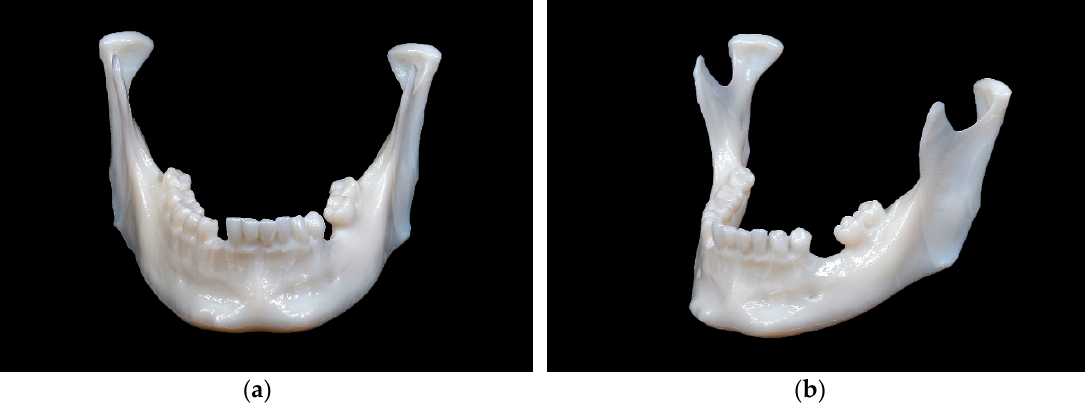
Figure 6. Mandibular model printed in material jetting (MJ) technology: ( a ) front view; ( b ) side view.